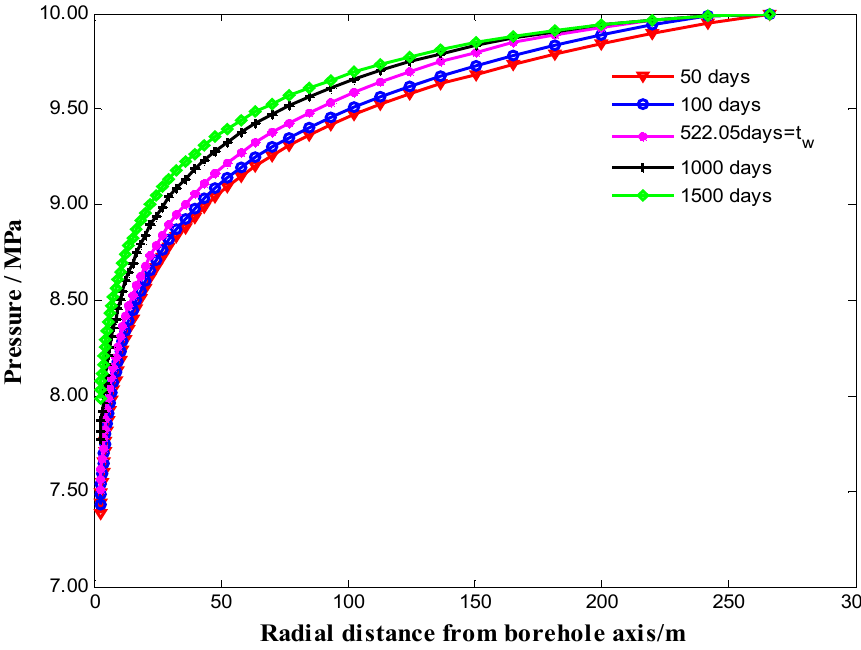
Figure 11. Pressure distribution (P) of the pay zones with different production period.